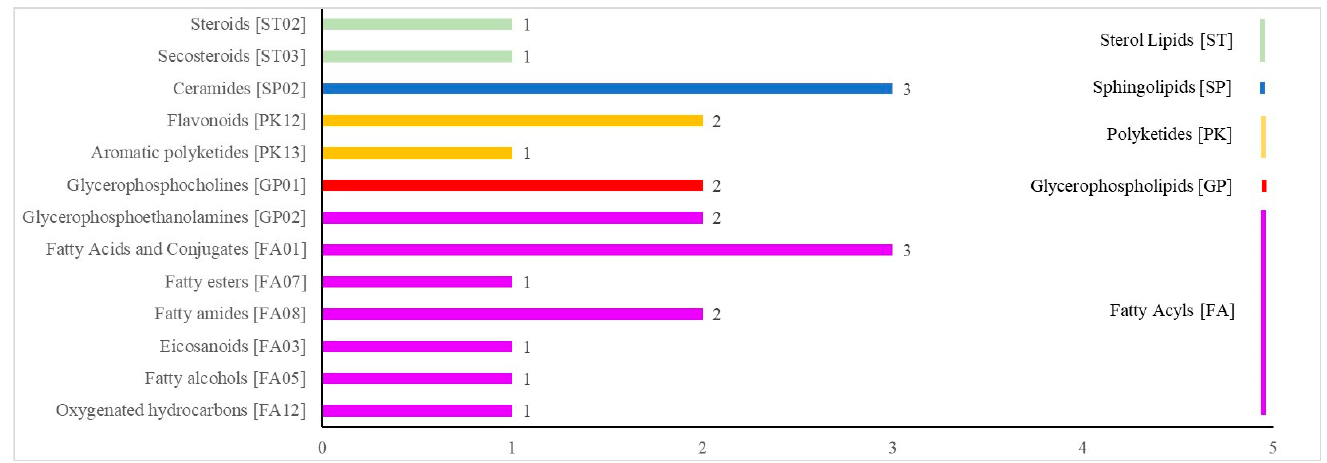
Figure 5. The HMDB annotations of differential metabolites. The abscissa is the number of differ ‐ Figure 6. The LMSD annotations of differential metabolites. The abscissa is the number of differential ential metabolites involved. metabolites involved.